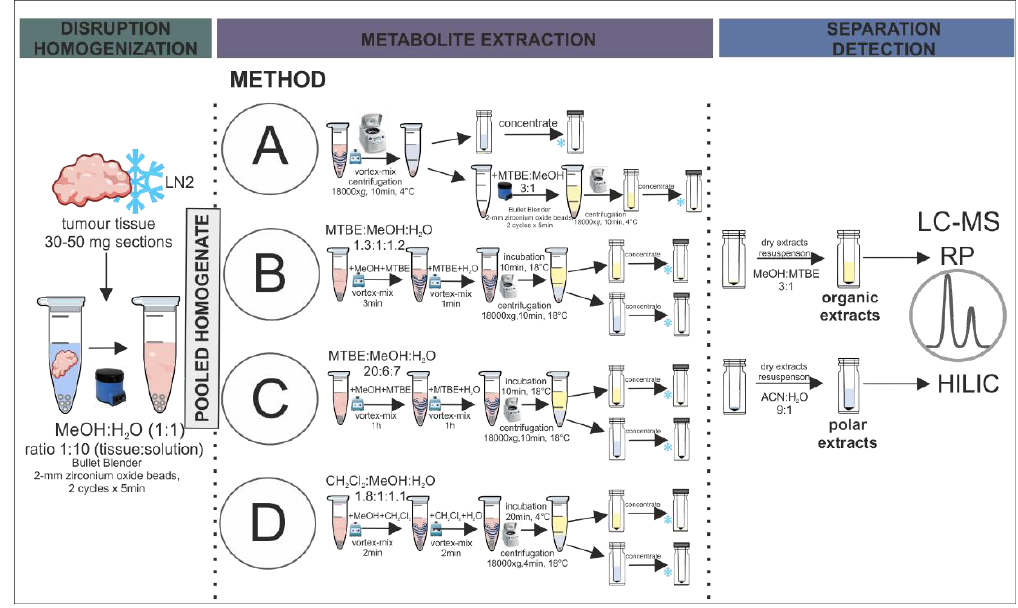
Figure 1. Schematic presentation of the step-by-step workflow of the selected extraction protocols evaluated in the study.